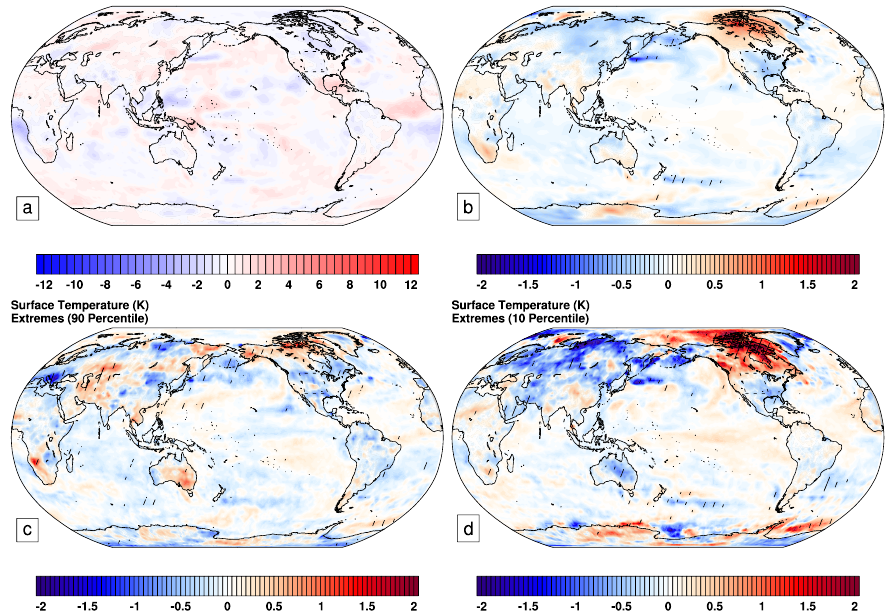
Figure 8. For intermittent RRM simulation: ( a ) effective radiative forcing (ERF, Wm − 2 ) at the top of the atmosphere; and ( b ) mean change in near-surface air temperature (SAT, K) response. Hatched areas in ( b ) are grid cells where significant at the 90% level by the t -test. Change in ( c ) top decile (90th percentile) ( d ) bottom decile (10th percentile) of temperature distribution. The difference shown are 30-year ensemble ensemble average between the HW suppression and control simulations (In Figure A2, the light blue lines indicate control simulation and the dashed red line in the intermittent simulation represents the ensemble part). Hatched areas in ( c , d ) are grid cells where significant at the 90% level by the t